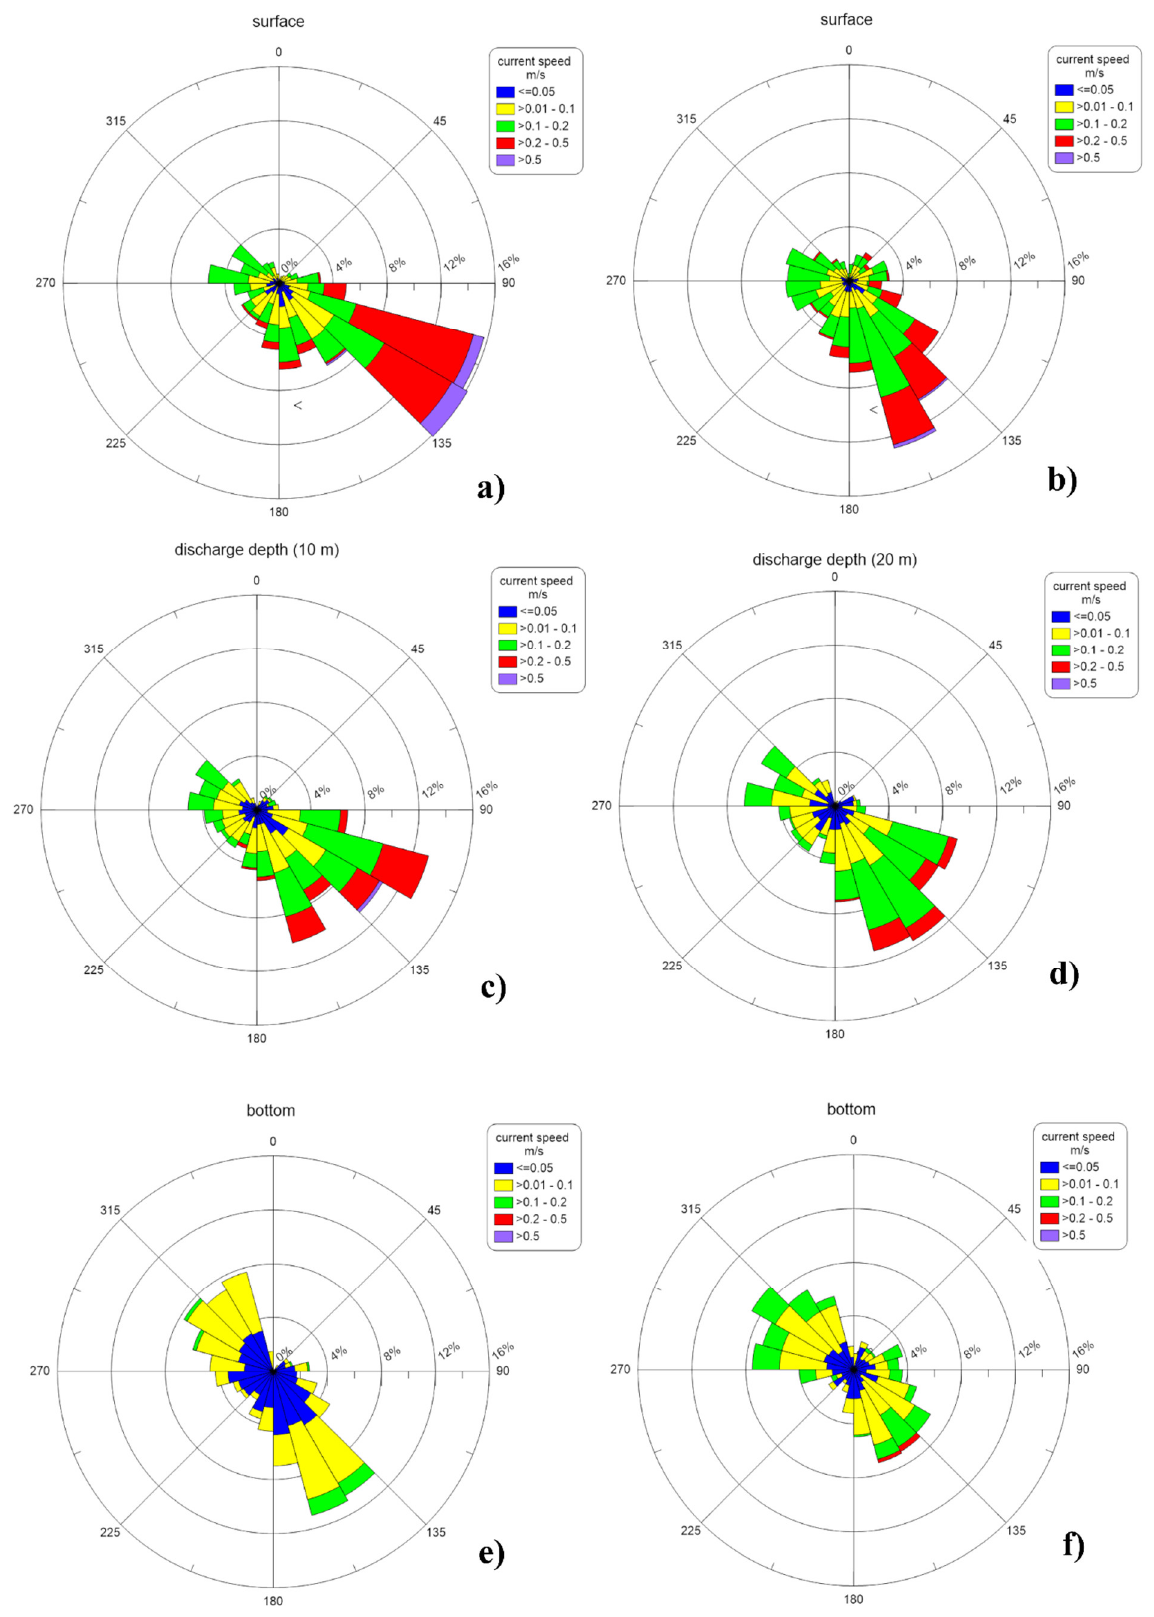
Figure 8. Current chart, representing the frequency with which the current flows towards a given direction, computed by MIKE 3 HD at three different depths: surface, discharge depth, bottom depth for the Plt A ( a , c , e ), and Plt B site ( b , d , f ).